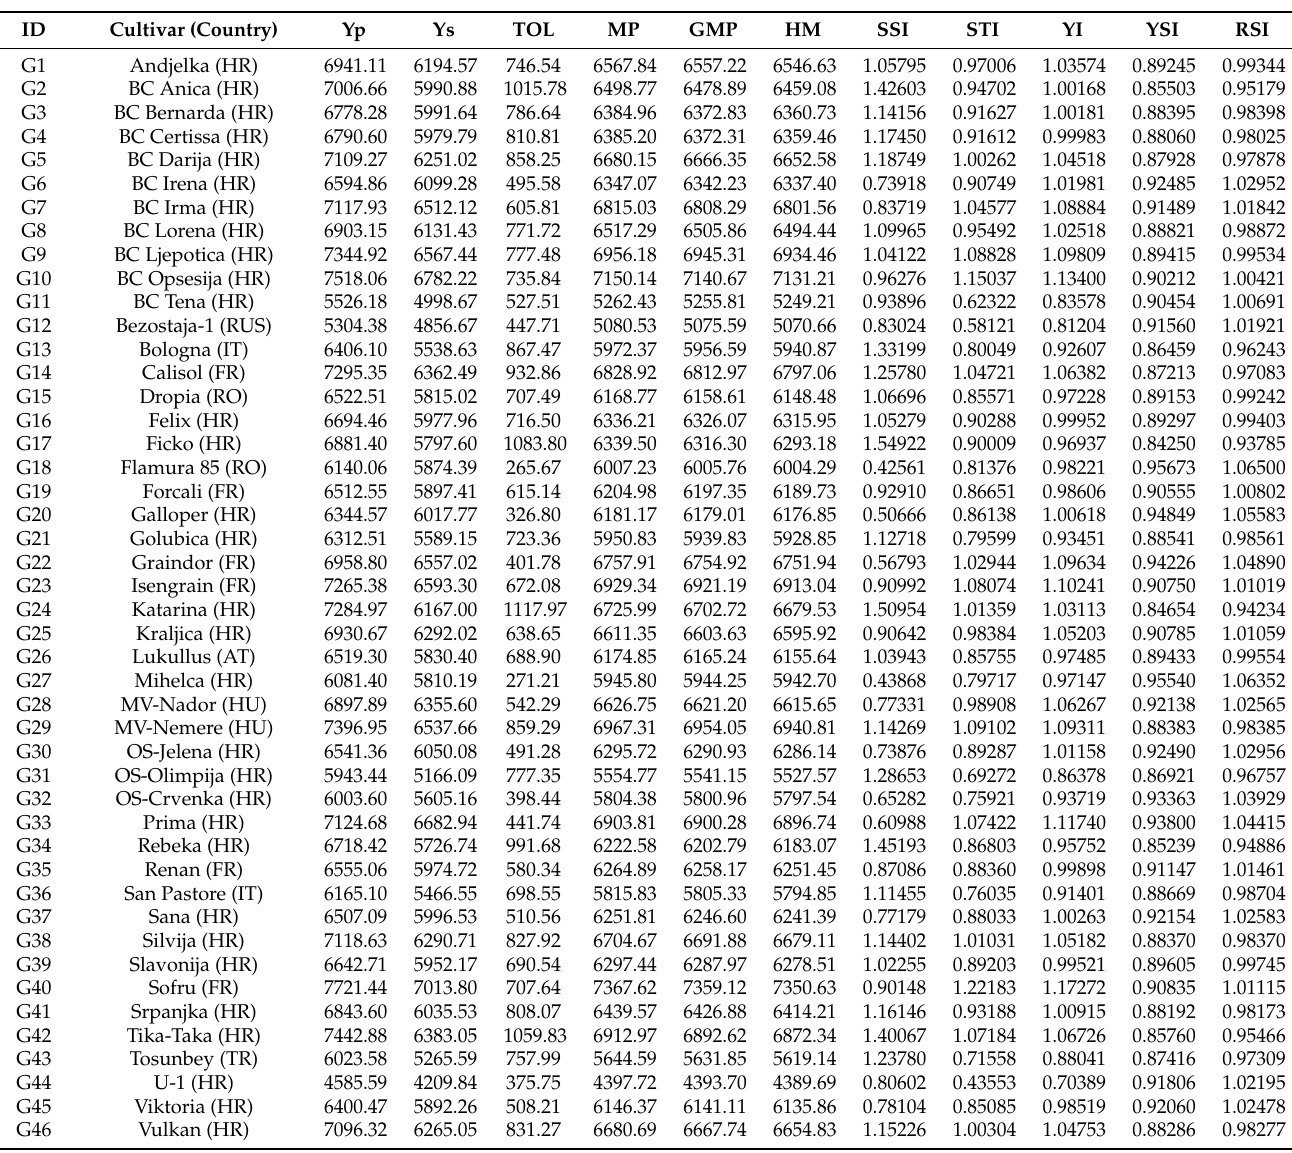
Table 3. BLUP values for the grain yield (kg ha − 1 ) and stress screening index